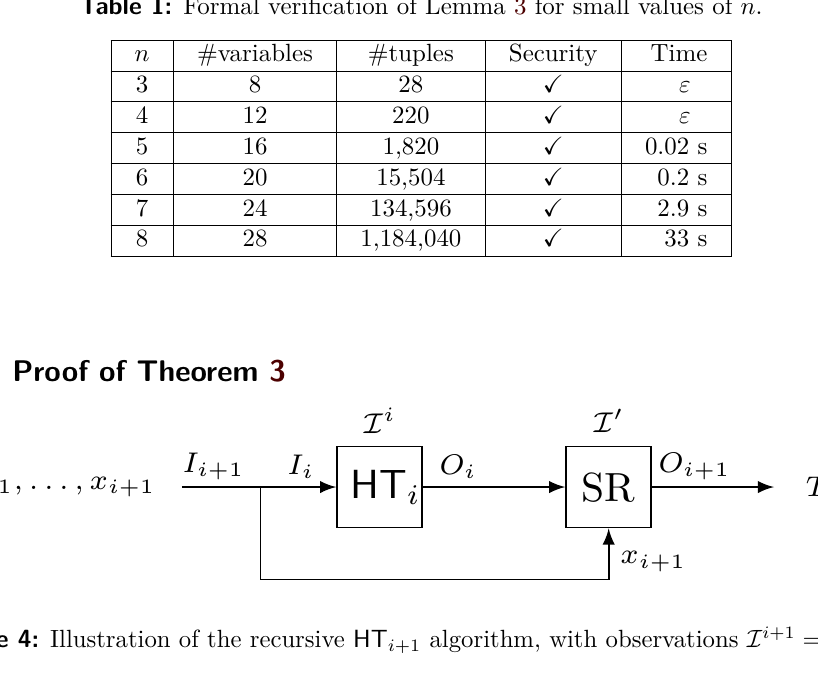
Table 1: Formal verification of Lemma 3 for small values of n .